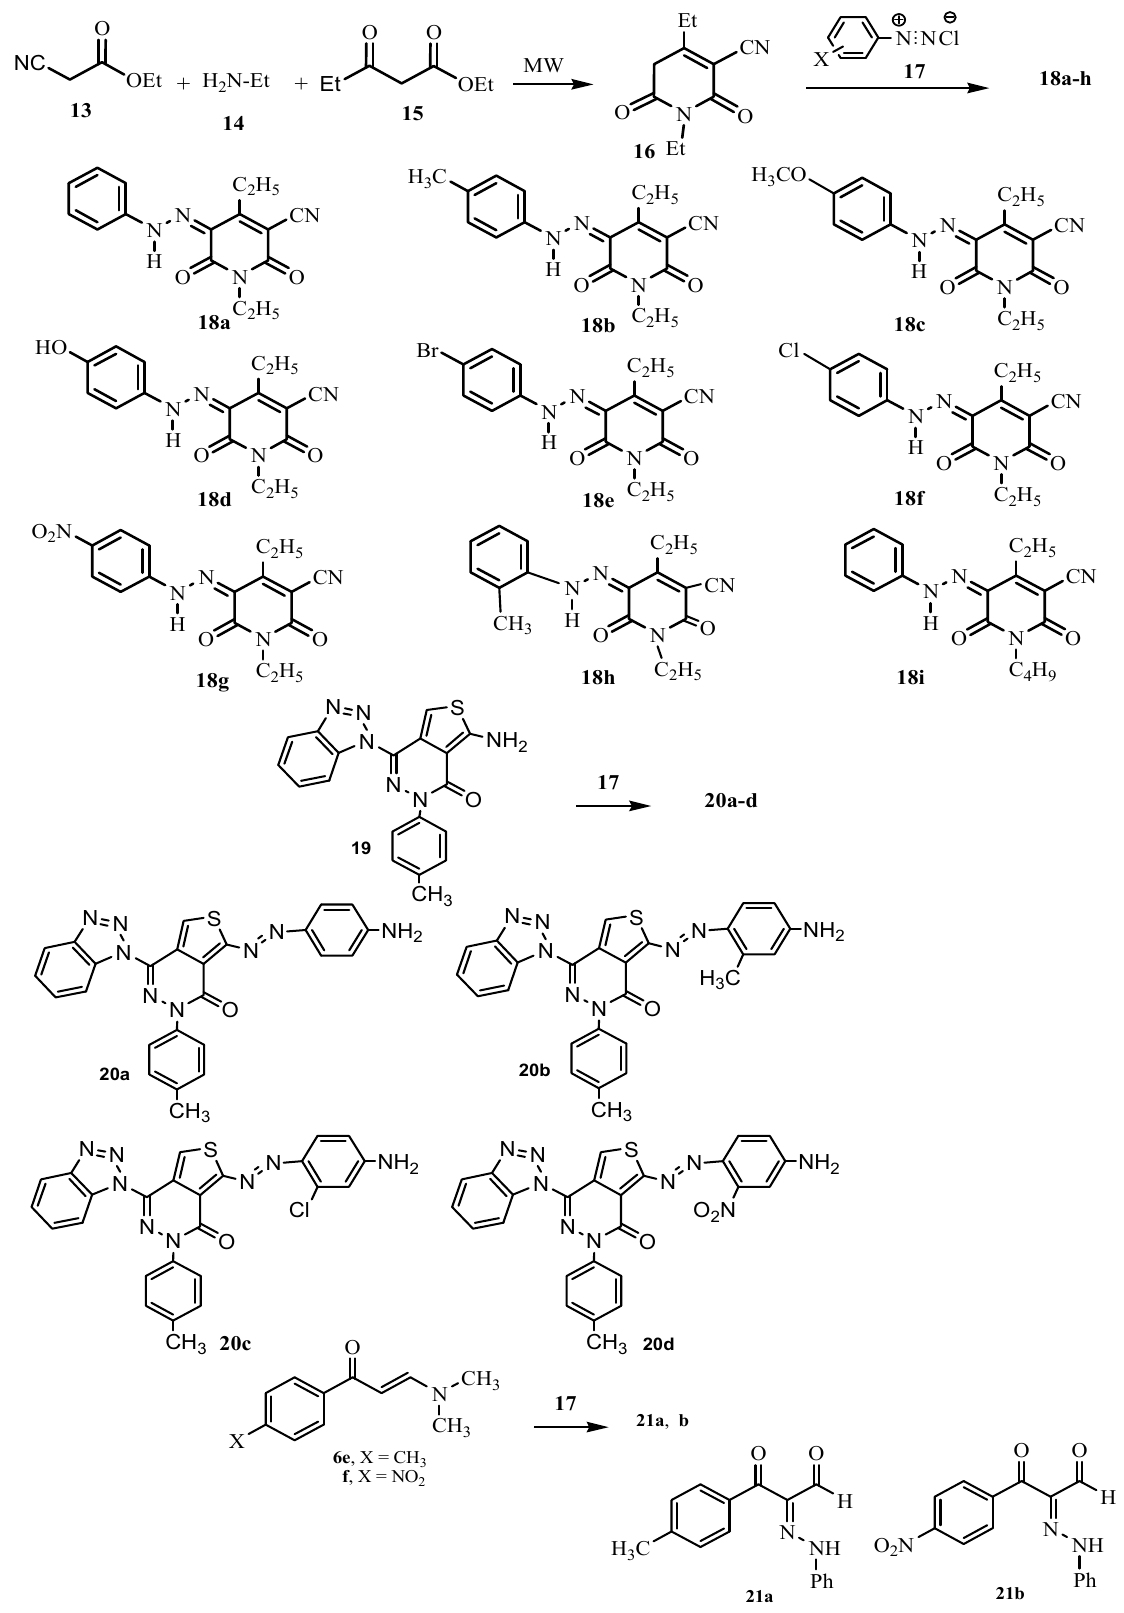
Scheme 3. The synthesis of disperse dyes based on pyridones moieties18a–i.